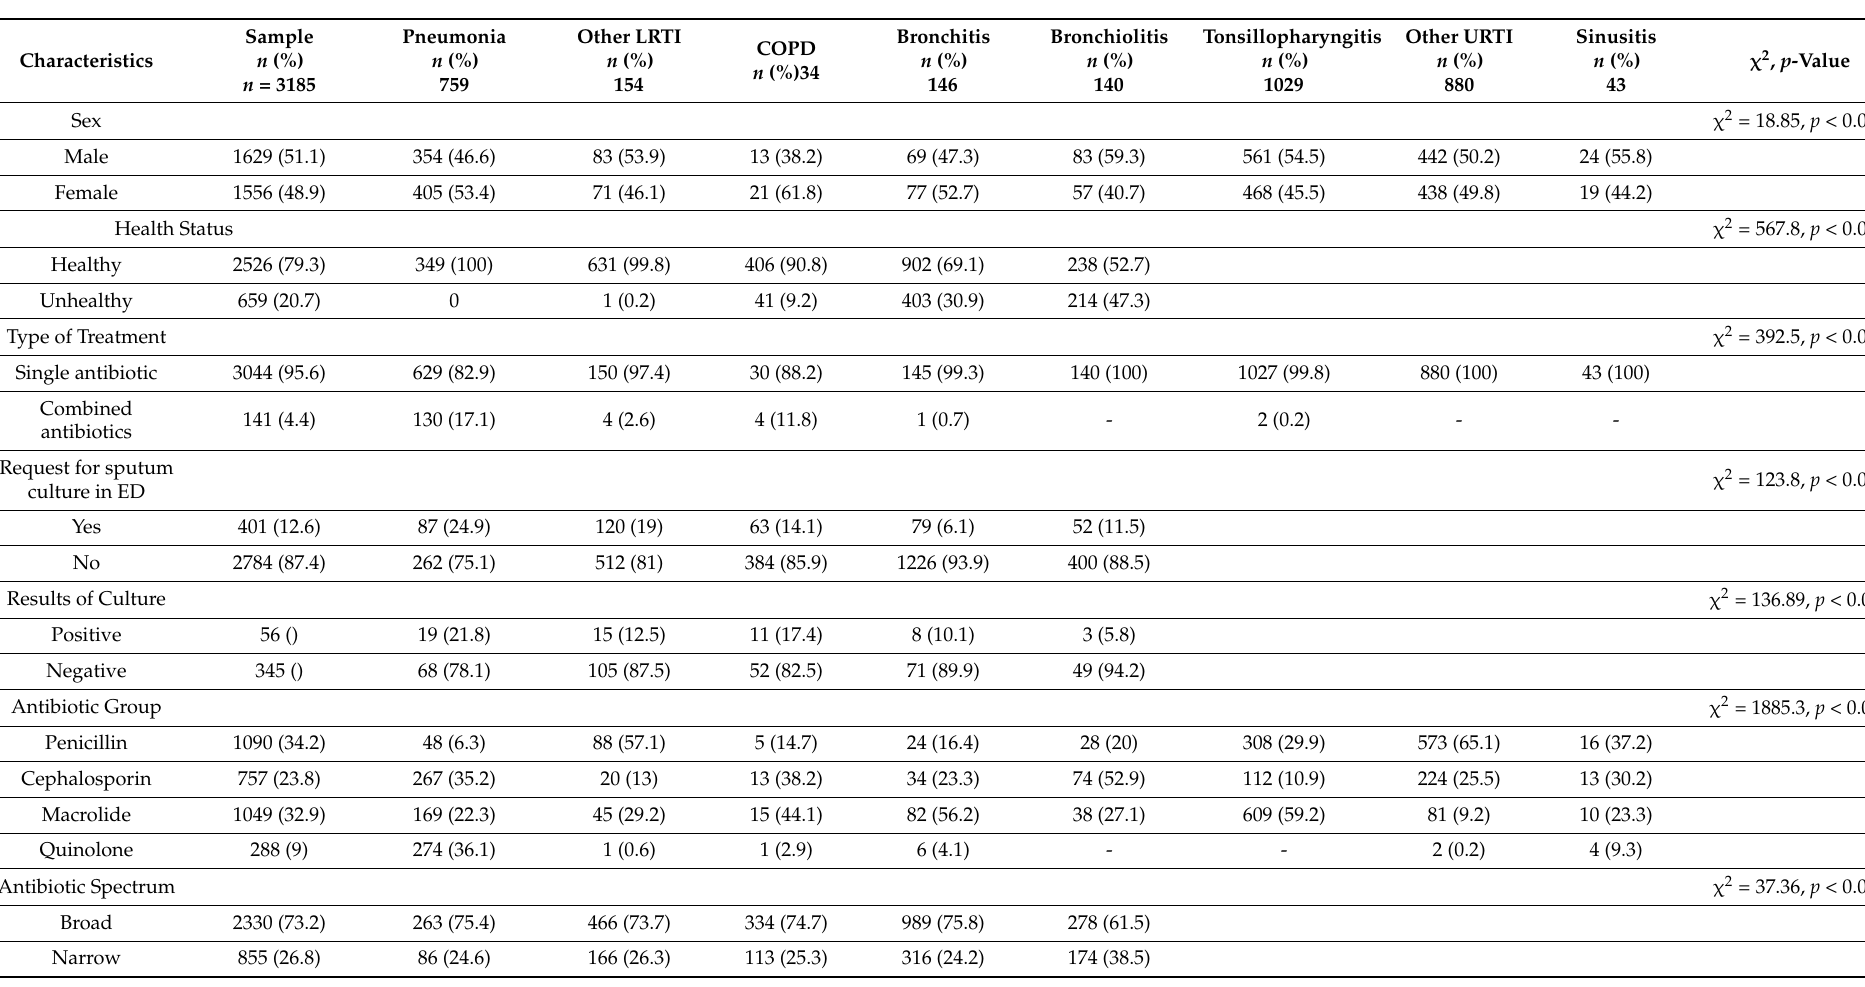
Table 3. Bivariate analysis of inappropriate antibiotic prescriptions as compared by